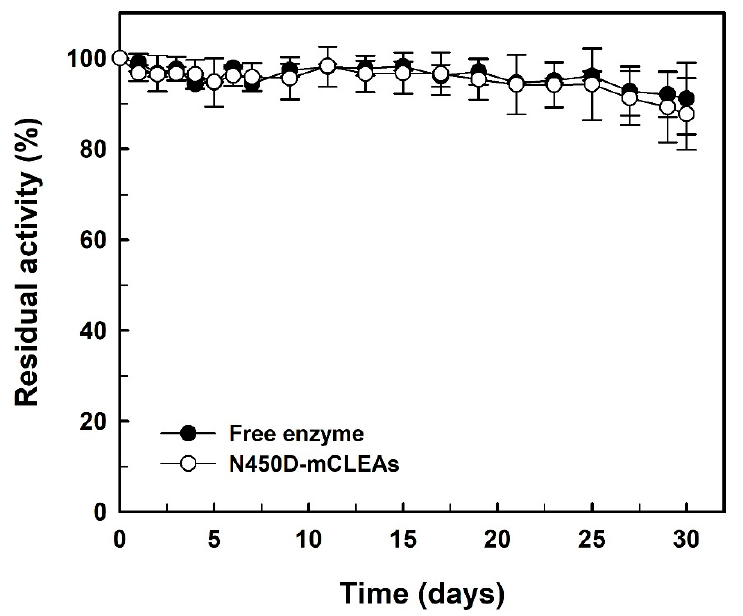
Figure 7. Storage stability of N450D and N450D-mCLEAs. The data are the average of three independent experiments with standard deviations.